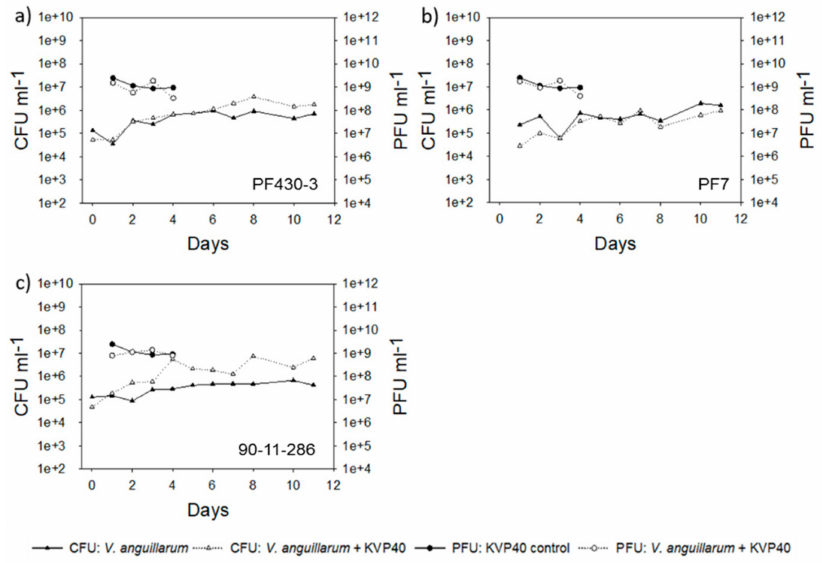
Figure 6. Bacterial abundance (CFU mL − 1 ) and phage abundance (PFU mL − 1 ) in cod challenge trial 1: ( a ) strain PF430-3; ( b ) strain PF7; ( c ) strain